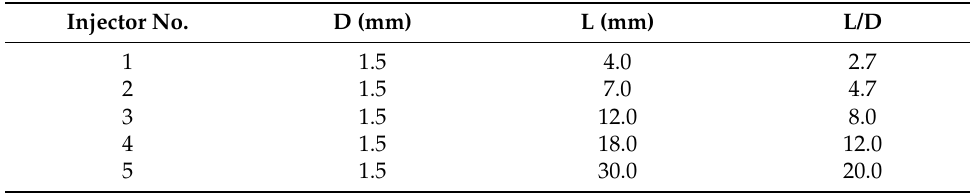
Table 1. The geometry of the injector orifices used in the study. Injector